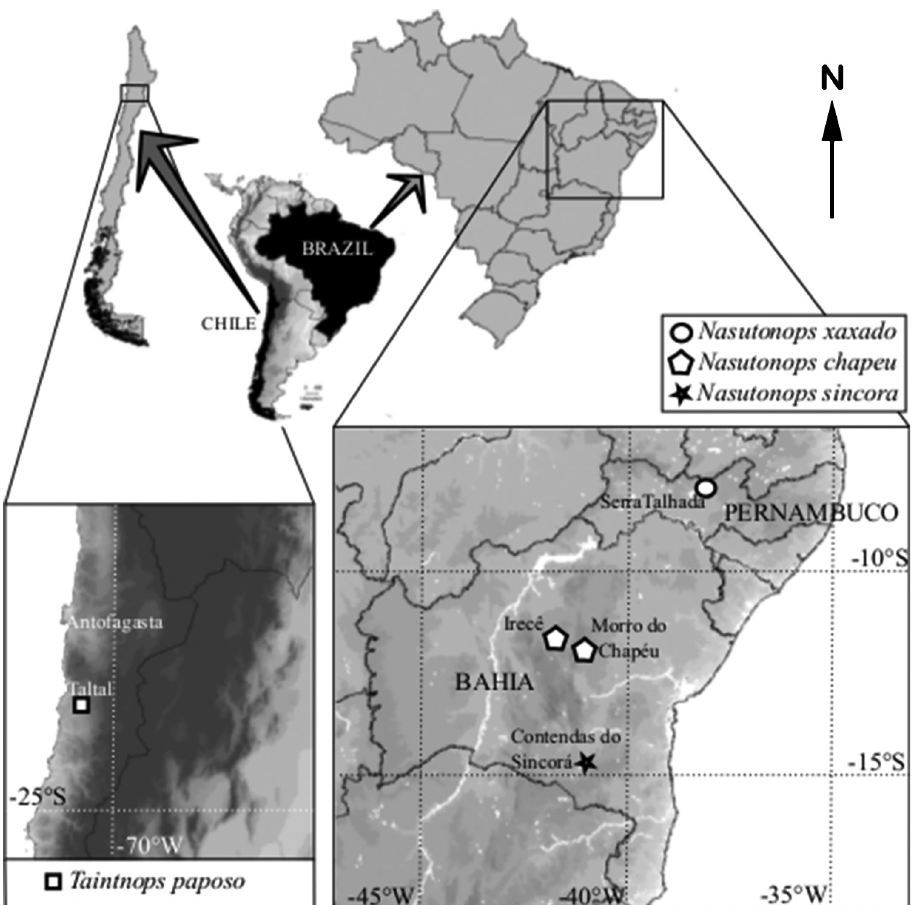
Figure 19. Distribution maps of Nasutonops species from the states of Bahia and Pernambuco, Brazil, and Taintnops paposo sp. n. from